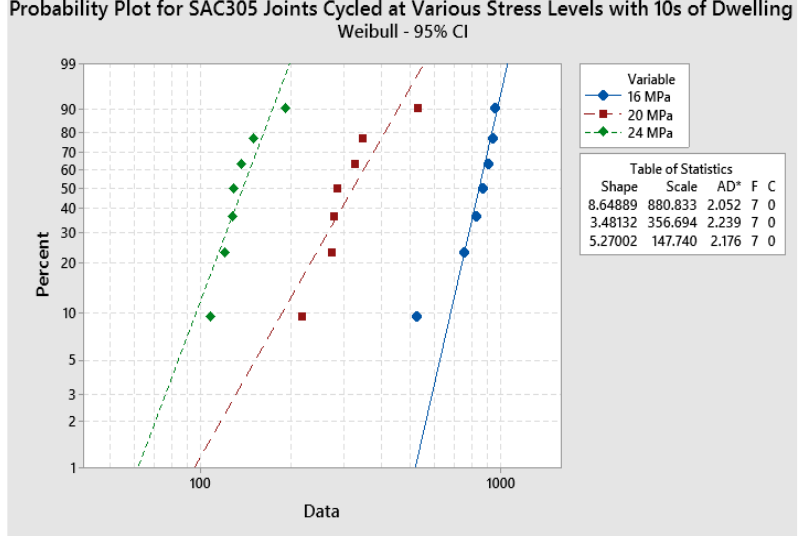
Figure 10. Weibull distributions for SAC305 joints cycled at different stress amplitudes at 10 s dwelling.